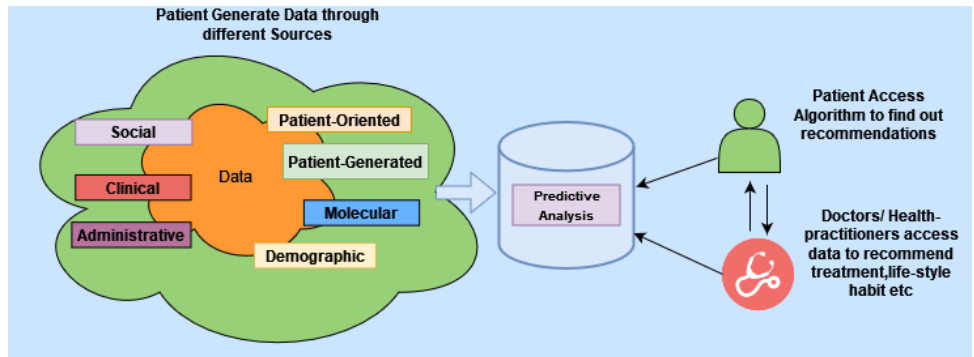
Figure 1. PH Healthcare Architecture.